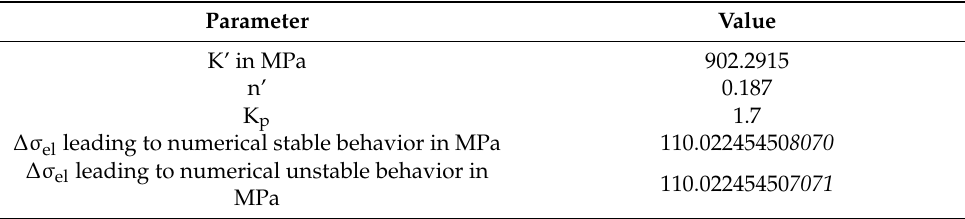
Table 1. Exemplary selection of parameters for which termination criteria 1 and 3 lead to complex values when applying the notch root approximation according to Seeger and